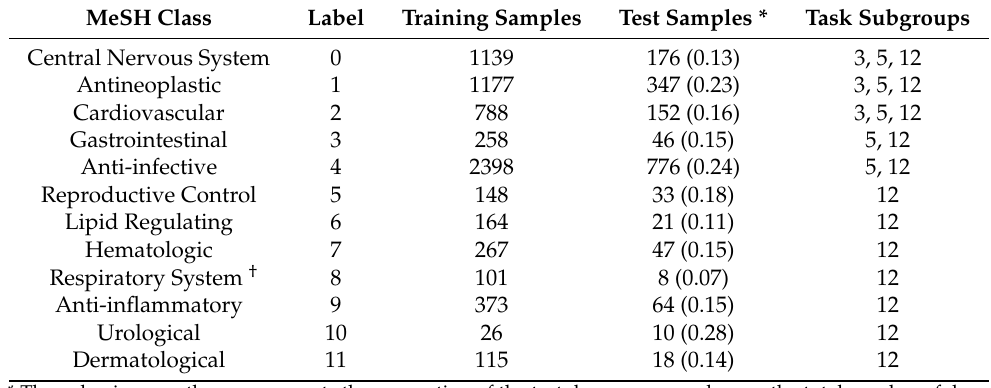
Table 1. Summary of the distribution of 6995 training samples and 1698 test samples. The test samples consisted of drug compounds that were not present in the training samples. The classification tasks to which drug compounds belonging to each MeSH class were subjected is provided under ‘Task Subgroups’. The 3-task subgroup means drug compounds belonging to the first three MeSH classes presented in the table were used in the single label classification task. Similarly, drugs belonging to the first five MeSH classes were used in the five-task subgroup single label classification task. In addition, all drugs were used in the 12-task subgroup single label classification. The integer values appearing under ‘Label’ are used to represent each MeSH class during modeling for single label